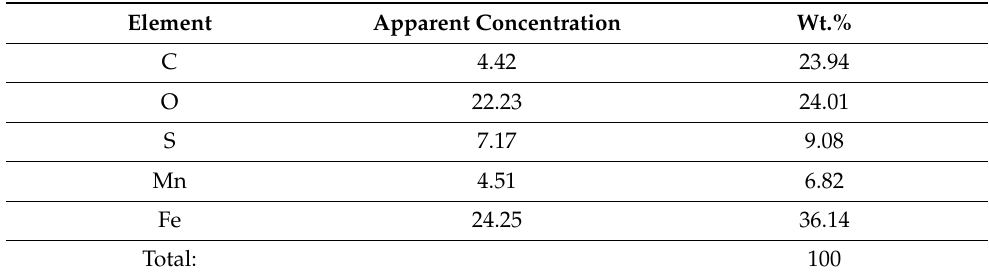
Table 2. EDX data of 5%S@MnFe 2 O 4